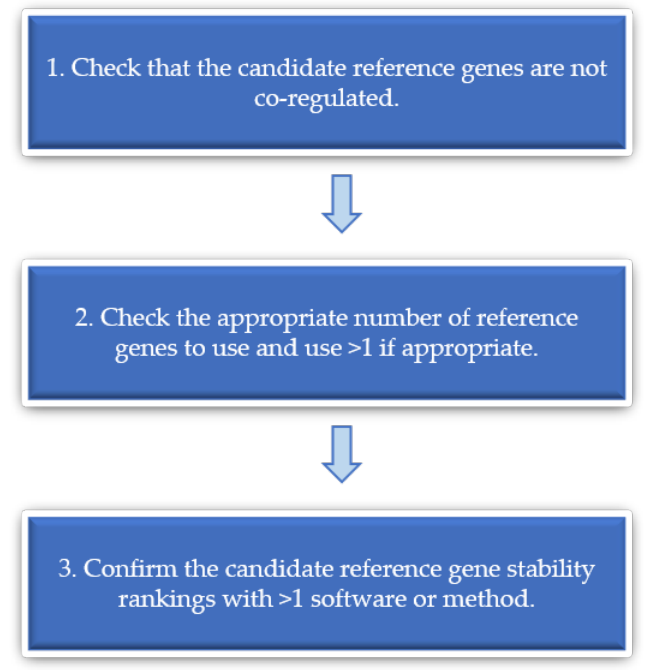
Figure 3. Recommended checkpoints to use when selecting reference genes. Supplementary Materials: The following are available online at https://www.mdpi.com/article/10.3390/genes12070960/s1, Table S1: Summary of experimental information for 90 RT-qPCR studies